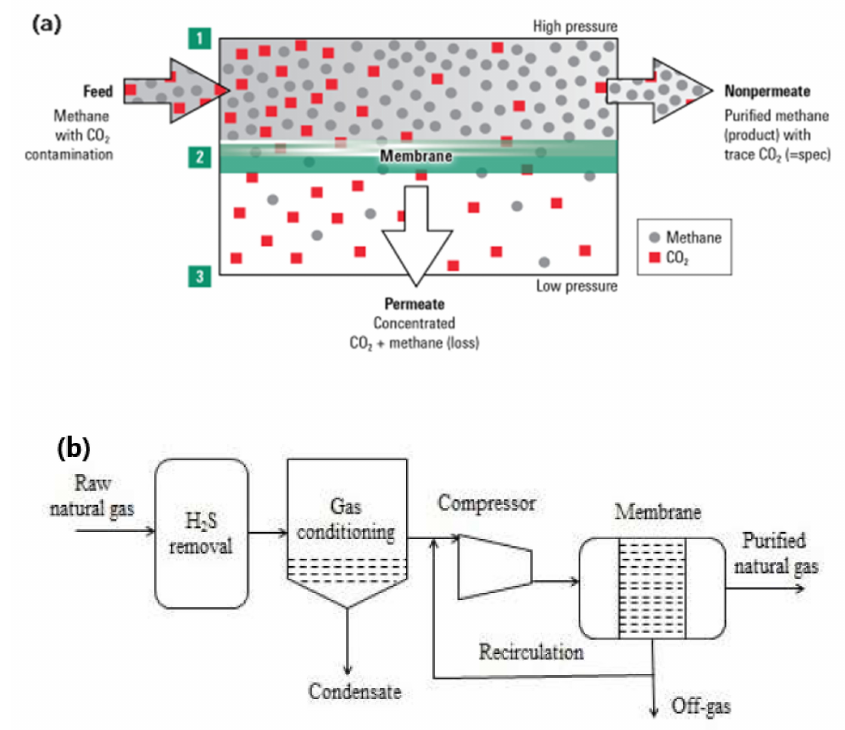
Figure 7. ( a ) Illustration of membrane-based gas separation process [23]. ( b ) Flow diagram of membrane separation process [23]. Reprinted/adapted with permission from Ref. [23]. Copyright 2022,